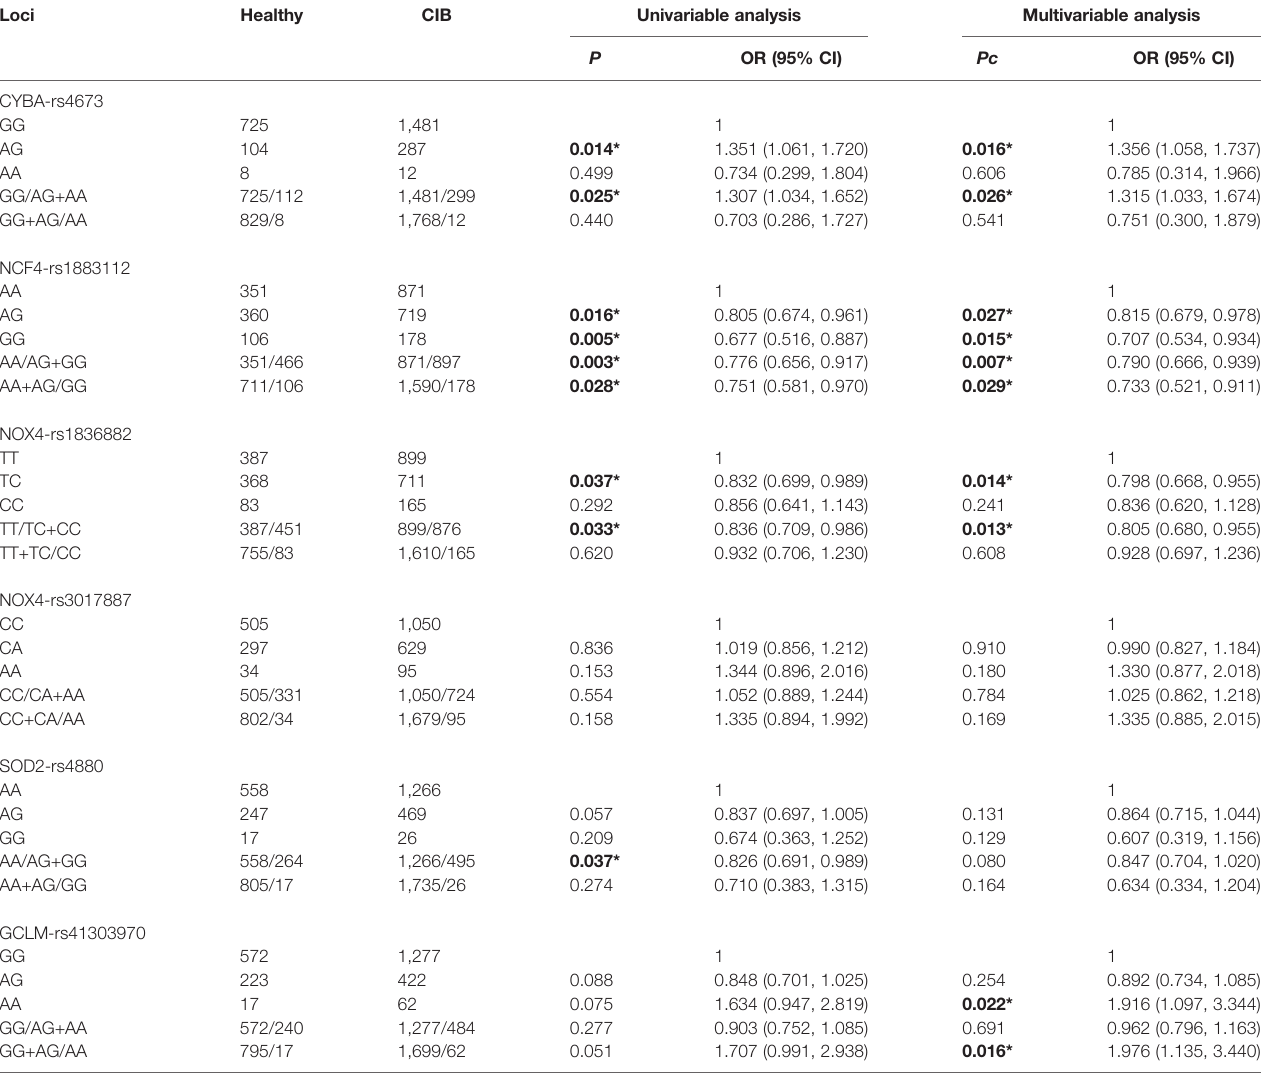
TABLE 3 | Logistic analysis of predictive factors with regard to the risk of hepatitis B virus-induced liver disease between healthy individuals and CIB group. Loci Healthy